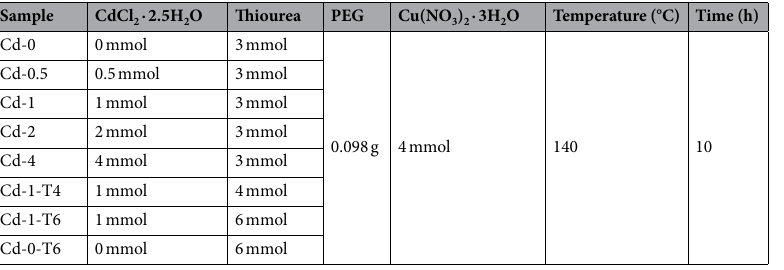
Table 1. The synthesis conditions for the preparation of